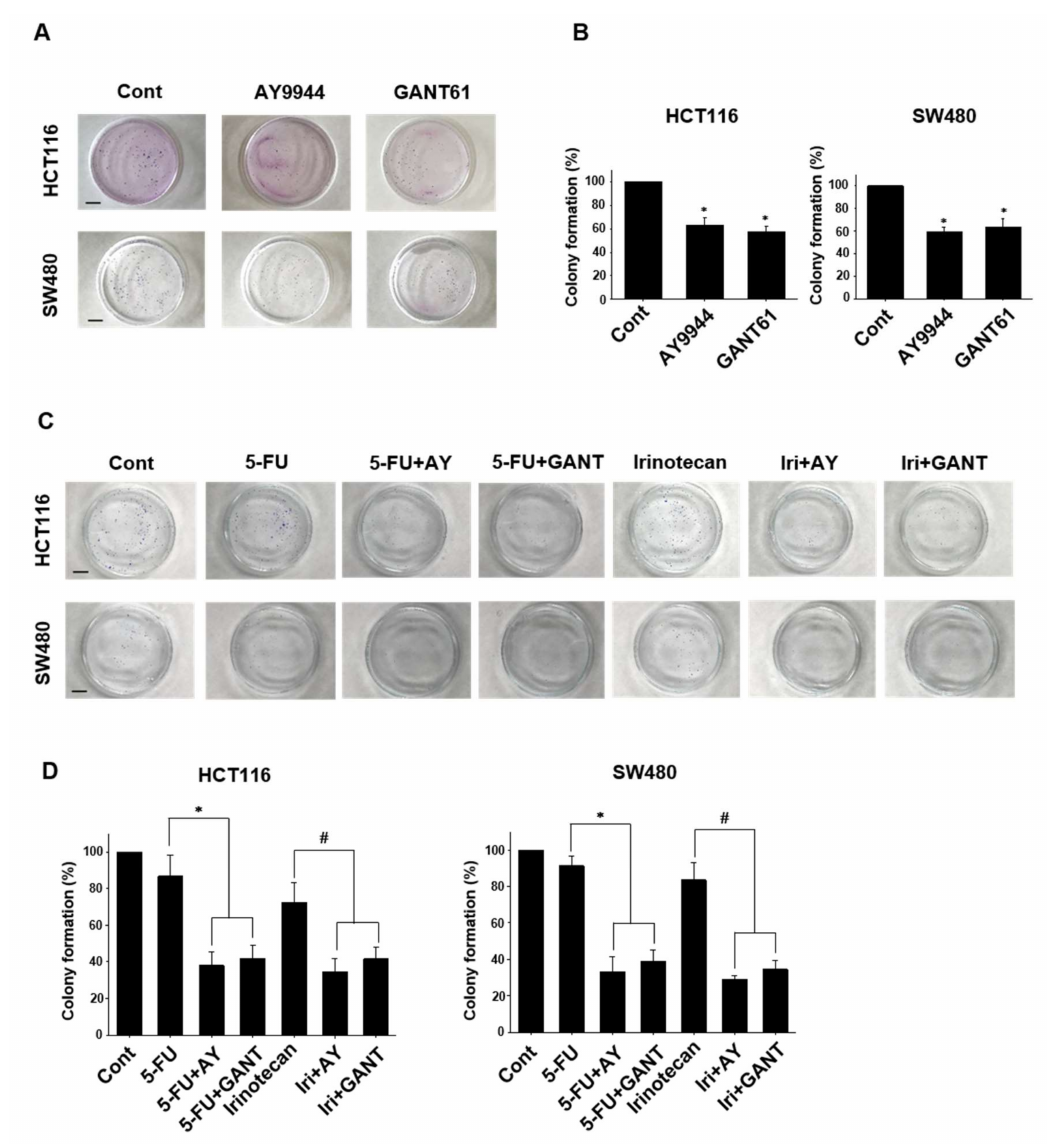
Figure 1. Effects of Hedgehog signal inhibitors on colony formation in colorectal cancer cell lines. After HCT116 and SW-480 cells were seeded on 6 cm-dish, they were treated with GANT61 (5 µ M) or AY9944 (5 µ M) for six days. Colony formation of HCT116 and SW-480 cells was determined by a colony formation assay. Representative photomicrographs were shown ( A ). Scale bar: 1 cm. After the membranes were fixed with 99.5% ethanol, colonies were stained with Giemsa. The number of colony was counted ( n = 4) ( B ). * p < 0.05 vs. Cont. Effects of co-treatment with Hedgehog signal inhibitors and anti-cancer drugs on colony formation in colorectal cancer cell lines. After HCT116 and SW-480 cells were seeded on 6 cm-dish, they were treated with 5-FU (0.1 µ g/mL) or Irinotecan (0.1 µ M) in the presence or absence of GANT61 (5 µ M) or AY9944 (5 µ M) for six days. Representative photomicrographs are shown ( C ). Scale bar: 1 cm. The number of colony was counted ( n = 6) ( D ). * p < 0.05 vs. 5-FU. # p < 0.05 vs.